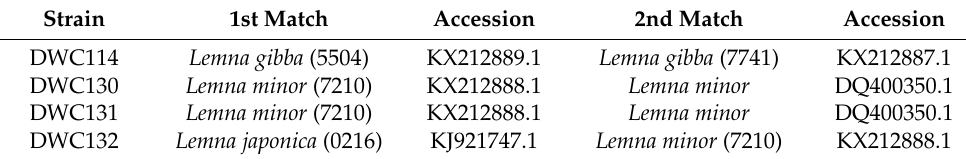
Figure 6. W. microscopica 2005 flowering and pollen analysis ( A ) Aerial view of mature W. microscopica 2005 fronds showing the pseudoroot (white arrowhead) extending from the ventral surface of a frond that is asexually reproducing a daughter frond at the same time it has produced a pistil. The pistil emerged from a furrow on the dorsal surface and has secreted stigmatic fluid (black arrow). A dehiscing anther has emerged from the furrow of a different frond (white arrow). ( B ) Side view of mature pistil with secreted fluid. ( C ) Side view of a dehiscing bilobed anther. Morphology is as described in Sree et al. [10]. Ruptured anthers releasing pollen ( D ) and pollen grains ( E ) stained with modified Alexander’s stain indicating that W. microscopica 2005 is producing viable pollen in culture. ( F ) 28% of W. microscopica 2005 pollen produced pollen tubes. Table 1. DNA Barcoding results showed that only DWC114 is L. gibba and that DWC130, DWC131, and DWC132 are L. minor . DNA barcoding results are given as the strain identification (genus and species, with ID in parentheses) and accession numbers for the first and second matches from BLAST [51] searches with the chloroplast atpH-atpF intergenic region from each